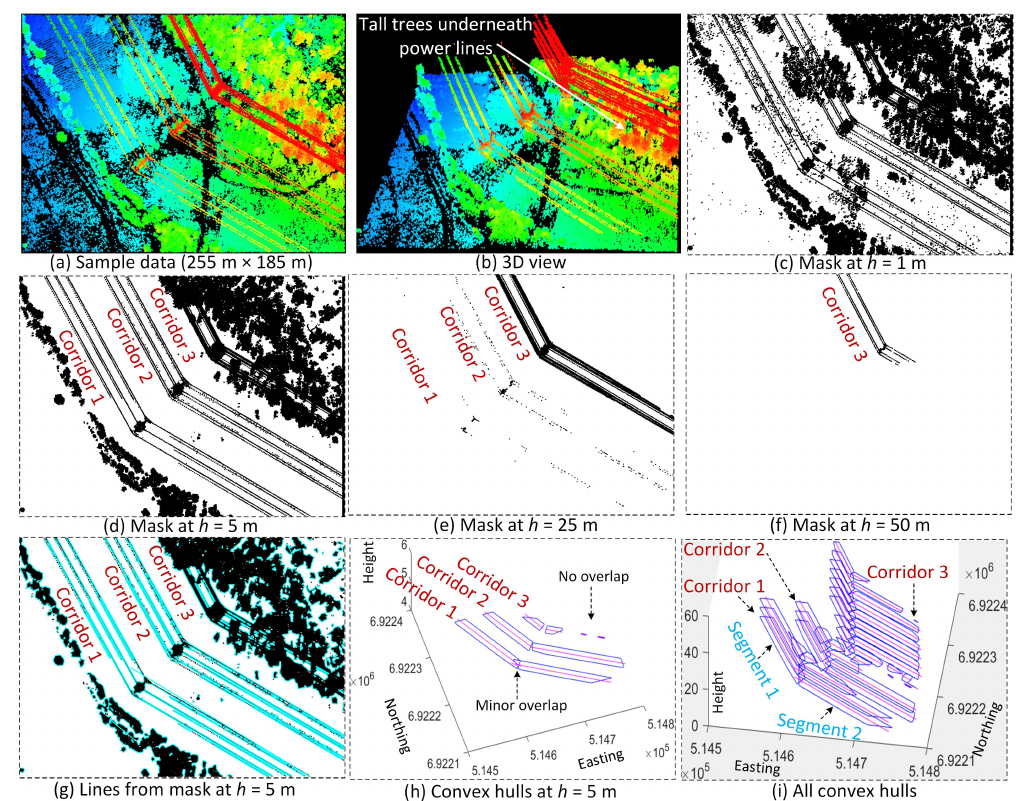
Figure 2. Sample input data and PL masks M h at different height levels h